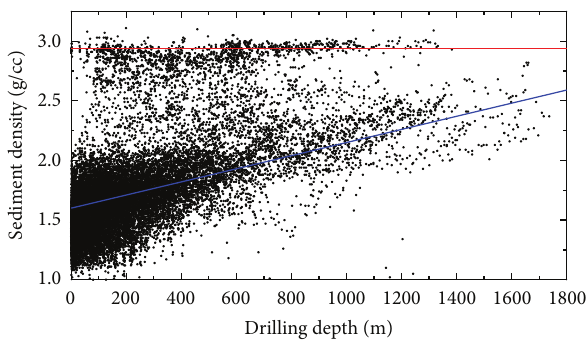
Figure 3: Scatter plot of the DSDP sediment density samples with respect to the drilling depths. The linear regression functions were used to approximate density trends within marine sediments (lower line) and bedrock samples (upper line). The chosen maximum sediment density is 2.60 g/cm 3 .